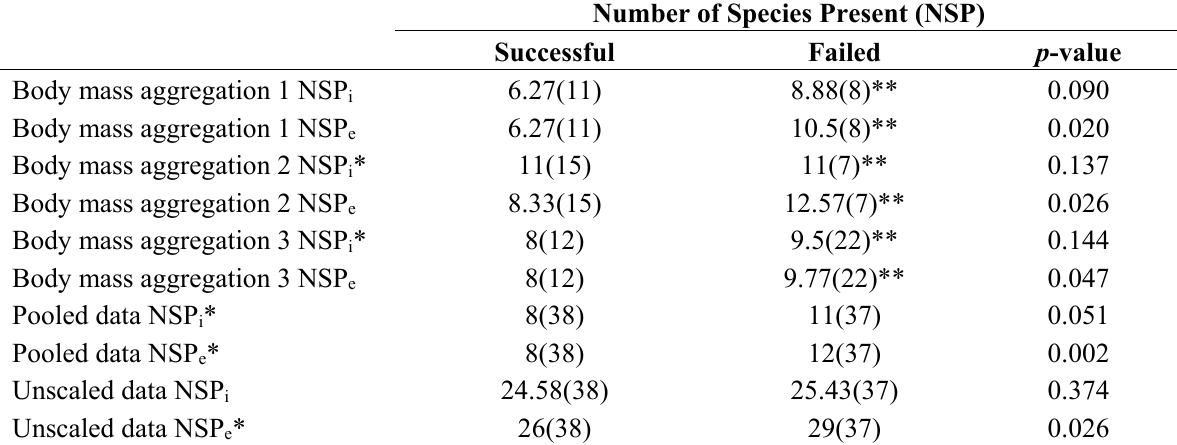
Table 2. Mean or median NSP i or NSP e values for Oahu birds in three different body mass categories, with body mass data pooled, and for unscaled data. Number of observations is given in parentheses.